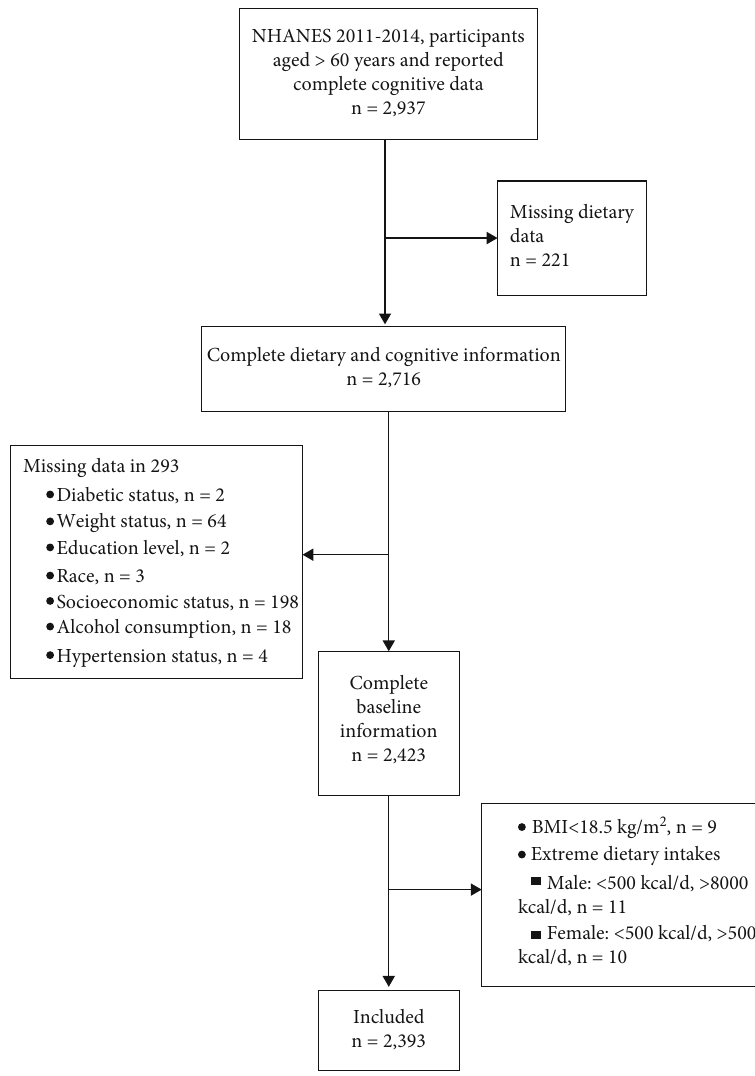
Figure 1: Flow chart of selecting eligible